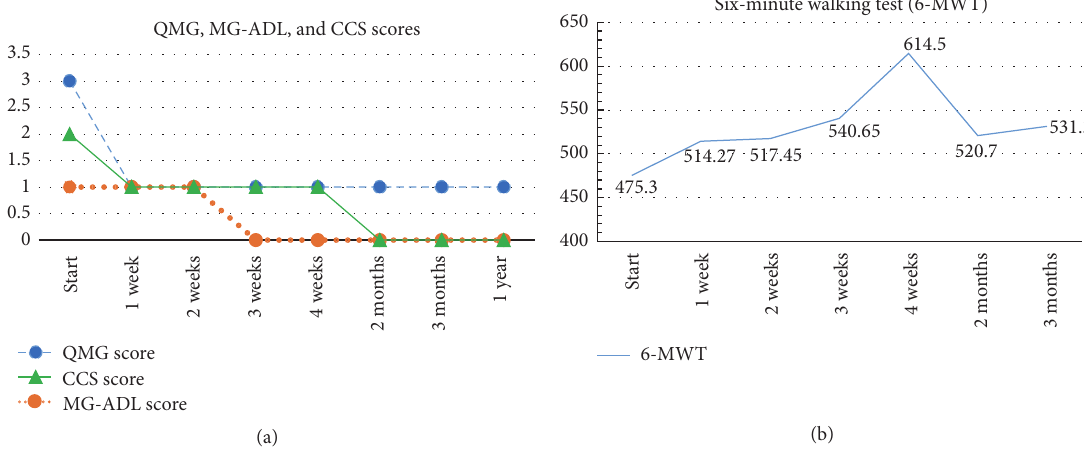
Figure 2: (a) Graphic shows QMG, MG-ADL, and CCS scores before and during the initial 12 months of therapy. (b) Graphic shows 6-MWT scores before and during the initial 4 weeks of therapy. (QMG: Quantitative Myasthenia Gravis test; MG-ADL: Myasthenia Gravis-specific Activities of Daily Living scale; CCS: Canadian Cardiovascular Society grading of angina pectoris; 6-MWT: 6-minute walking